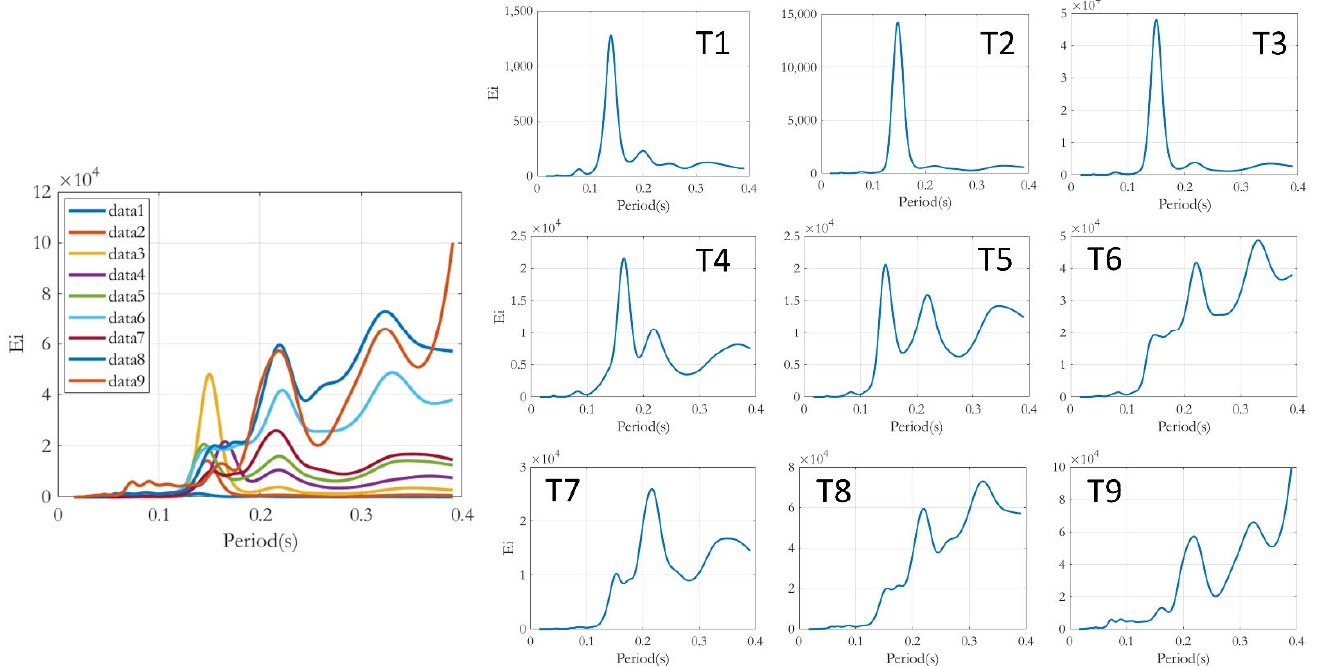
Figure 13. Extracting the wavelet envelope at a natural period Ti for each of the 9 Tests: ( Left ) all superimposed. ( Right ) one by one.